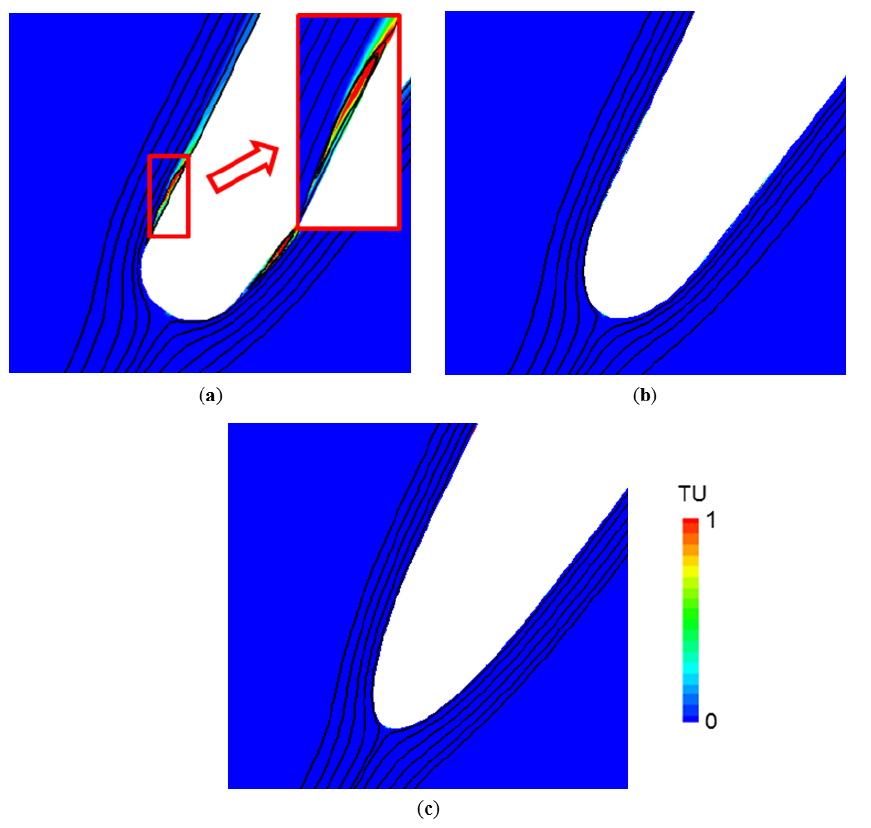
Figure 12. Streamlines and turbulence intensity distributions at α = 56°: ( a ) circular LE; ( b ) elliptical LE; ( c ) continuous-curvature LE.